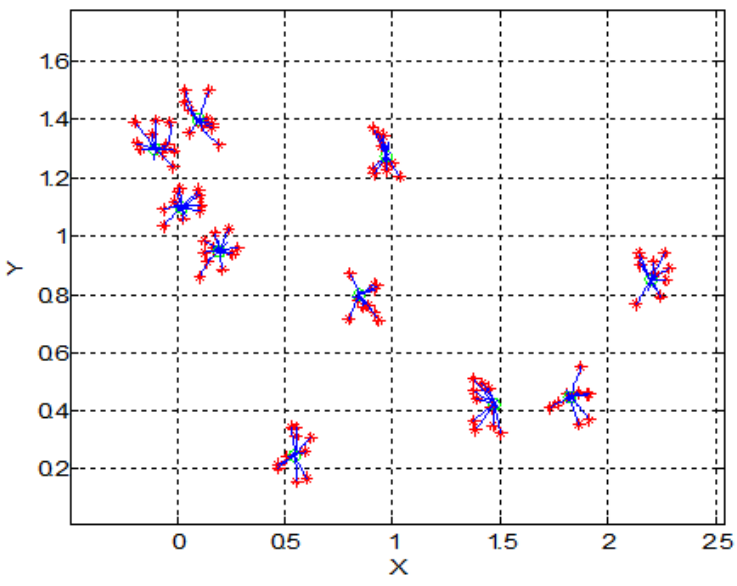
Figure 7. Trajectory of 100 nanoparticles under ten different magnetic field sources (Units of X and Y axes are mm).